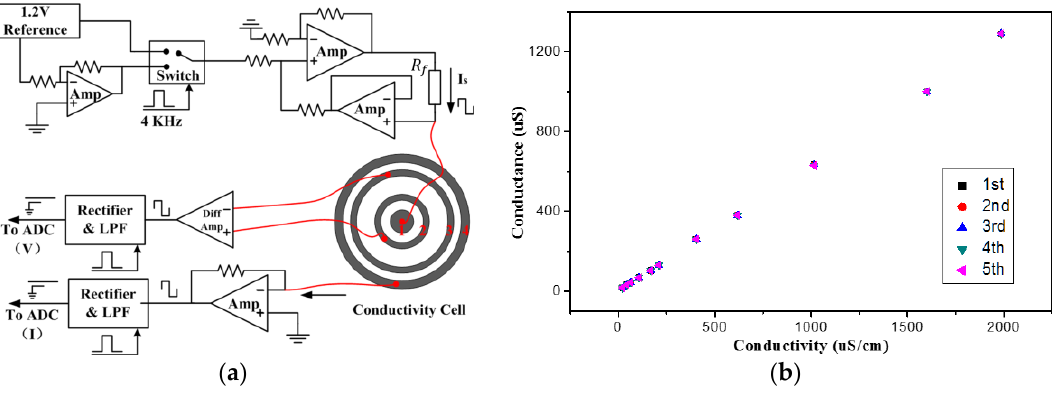
Figure 7. ( a ) Schematic of the trans-impedance measurement circuit; and ( b ) linear calibrition curve of the conductivity cell.